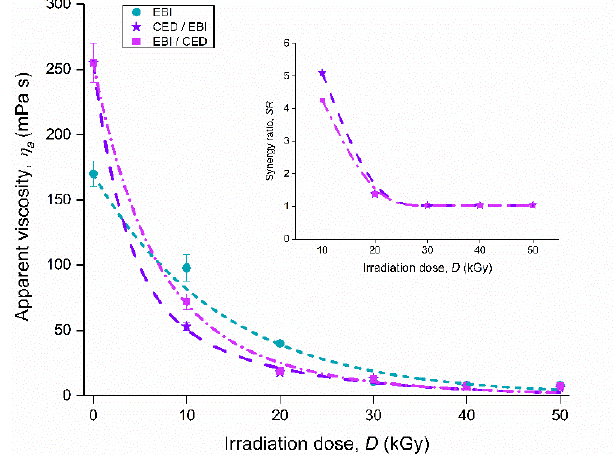
Figure 4. Evolution of the apparent viscosity (25 °C, γ = 200 s − 1 ) for modified starches depending on the irradiation dose. Inner window: Synergy ratio vs. irradiation dose for combined treatments (EBI/CED and CED/EBI).